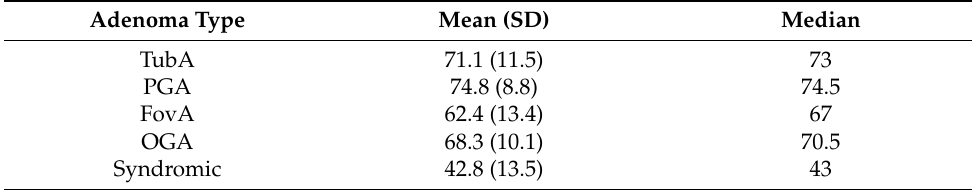
Table 2. Distribution of age at diagnosis within each adenoma type. TubA: intestinal-type adenoma; PGA: pyloric gland adenoma; FovA: foveolar-type adenoma; OGA: oxyntic gland adenoma; SD: standard